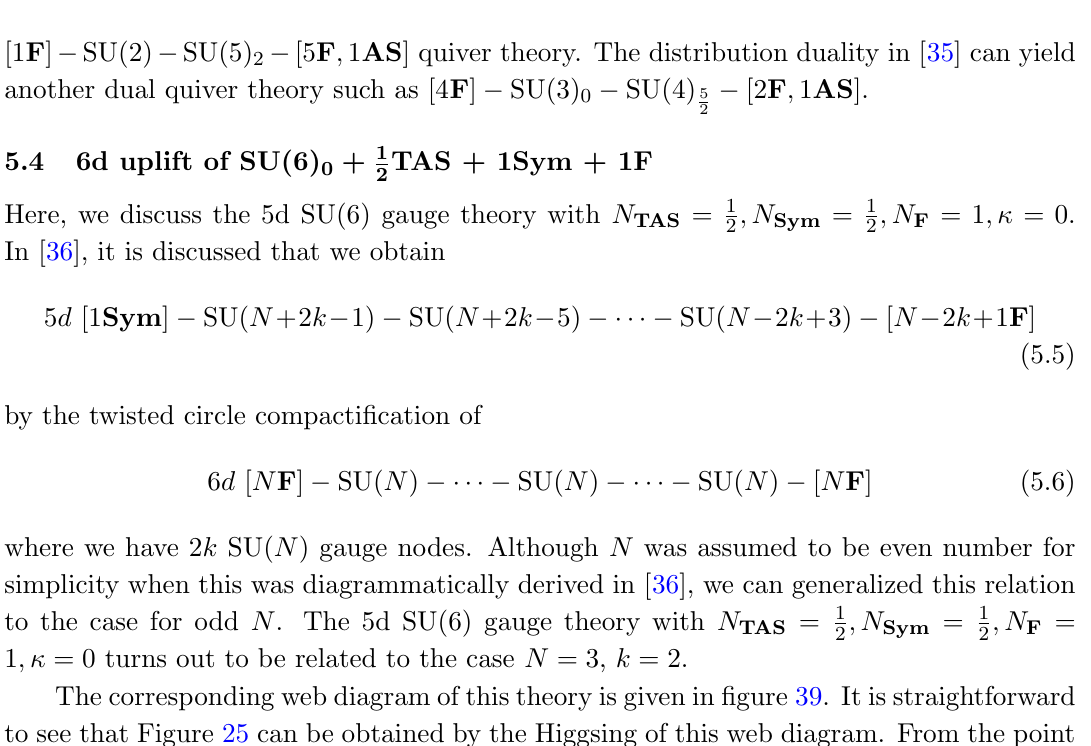
Figure 39 . Type IIB web diagram corresponding to twisted circle compacti(cid:12)cation of 6d SU(3) quiver gauge theory. All the ( p; 1) 5-branes are written vertically for